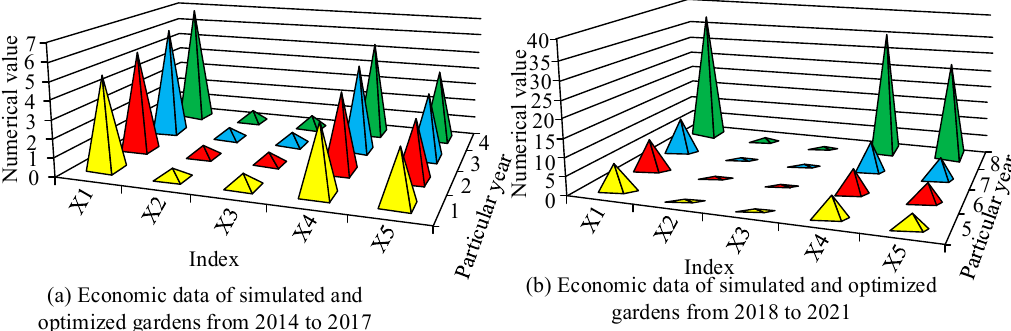
Figure 8. Economic benefits of the ecological garden in Lanshan Mountain after parametric design optimization.